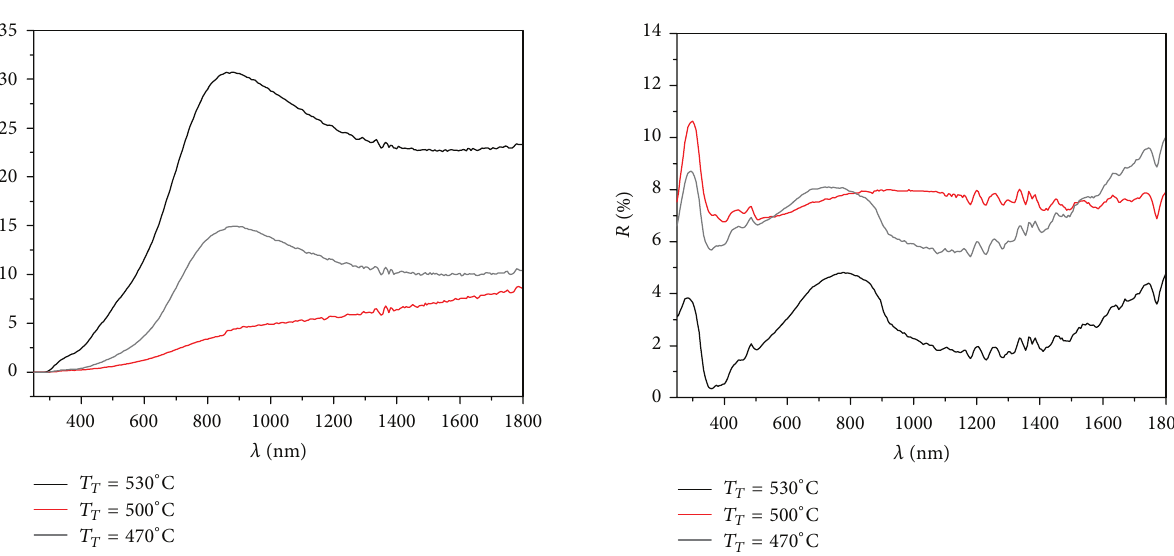
Figure 1: Transmission spectra of the as-grown iron ditelluride layers.